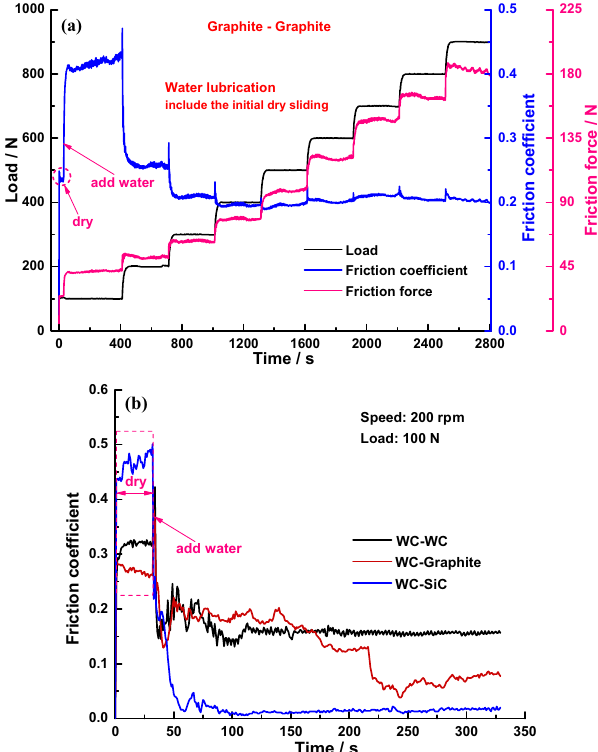
Figure 7. Variation of friction coefficient with running time under different external loads at a rate of rotation of 200 rpm, corresponding to 0.5 m/s, from initial dry sliding to the addition of water: ( a ) of phenolic resin- impregnated graphite sliding against itself, and ( b ) of cemented carbide (WC) sliding against itself, WC sliding against graphite and WC sliding against